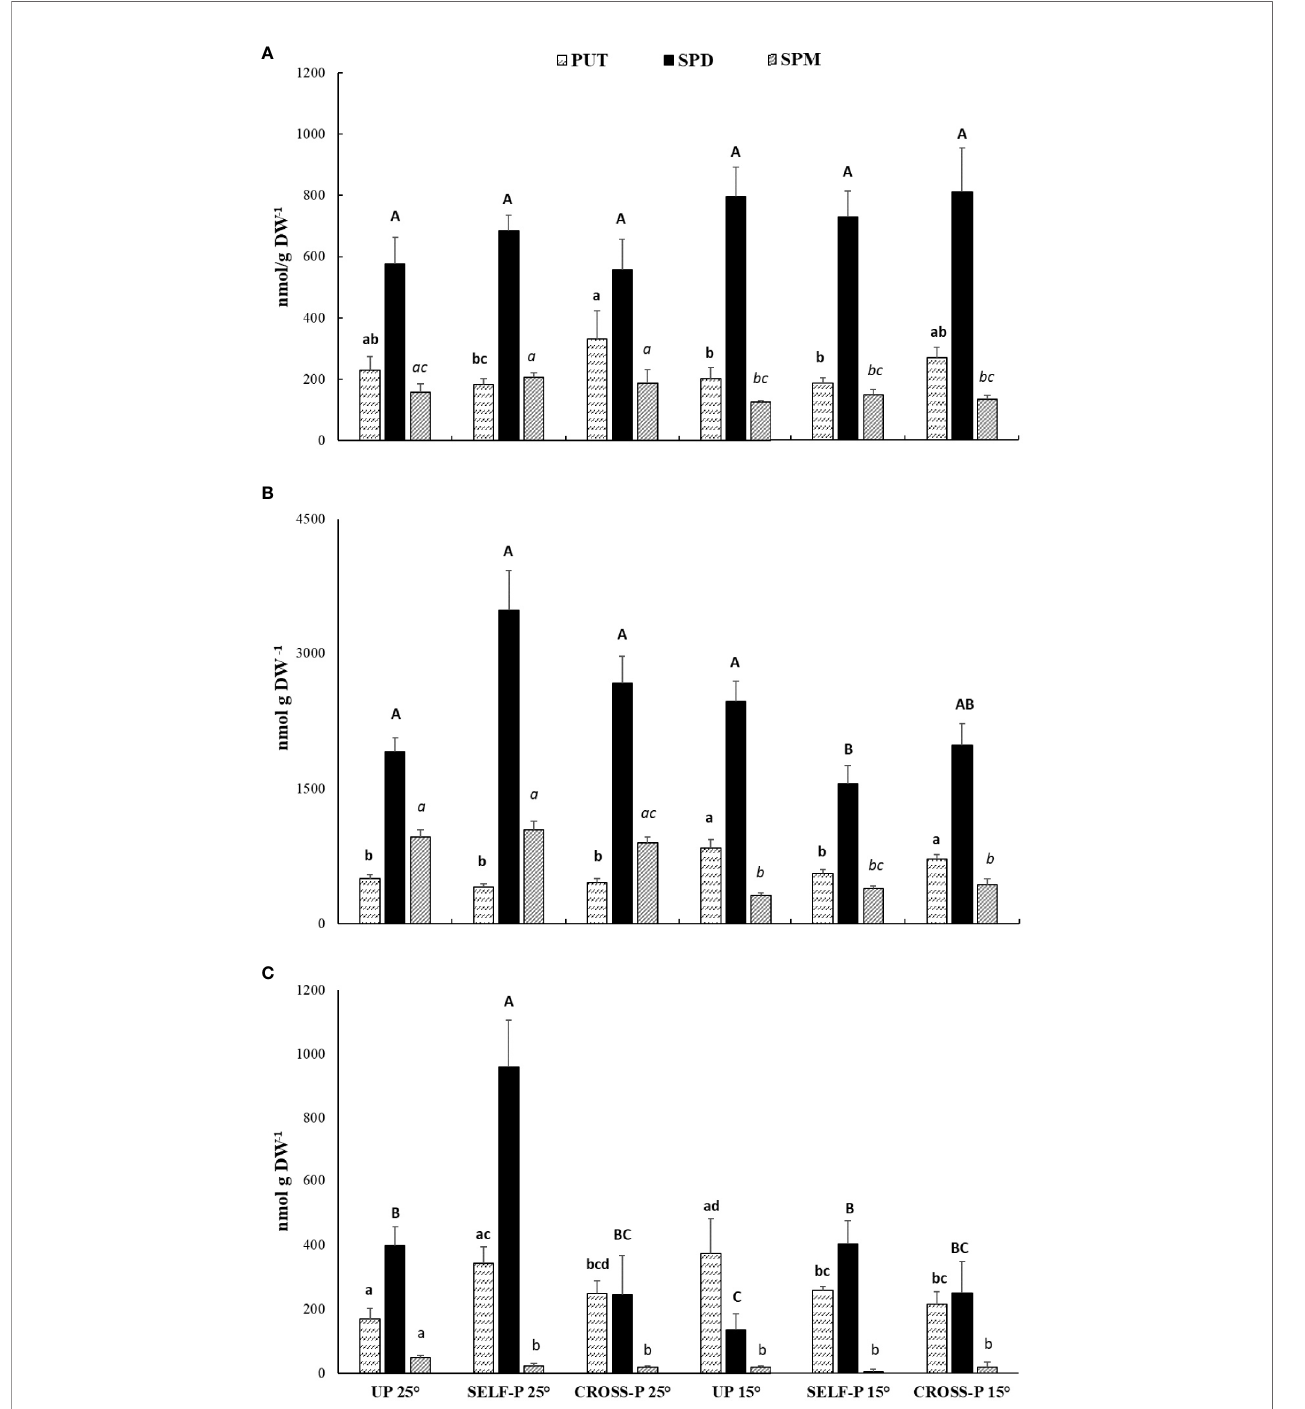
FIGURE 6 | HPLC analysis of PAs content. Free (A) , soluble-conjugated (B) and insoluble-bound (C) PAs in unpollinated, self-, and cross-pollinated pistils of C. clementina . The data were analyzed by two-way ANOVA test, with Bonferroni post-test. Values of p < 0.05 were considered statistically signi fi cant. Different letters indicate signi fi cant differences at p < 0.05. For each PA, a different font was used (Put, lowercase; Spd, uppercase; Spm, italics). Means ± S.D. of three experiments analyzed in triplicate are